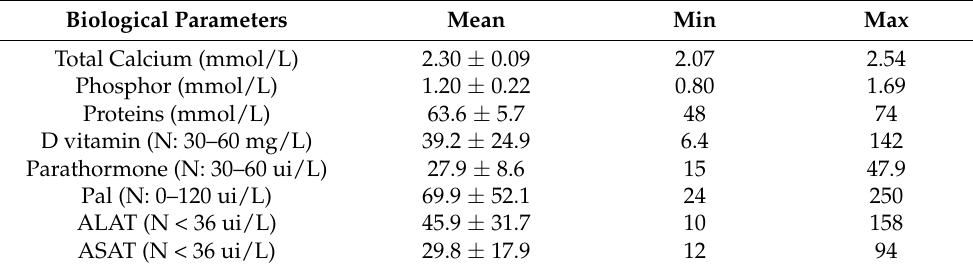
Table 2. Biological parameters at the beginning of the PMR hospitalization.